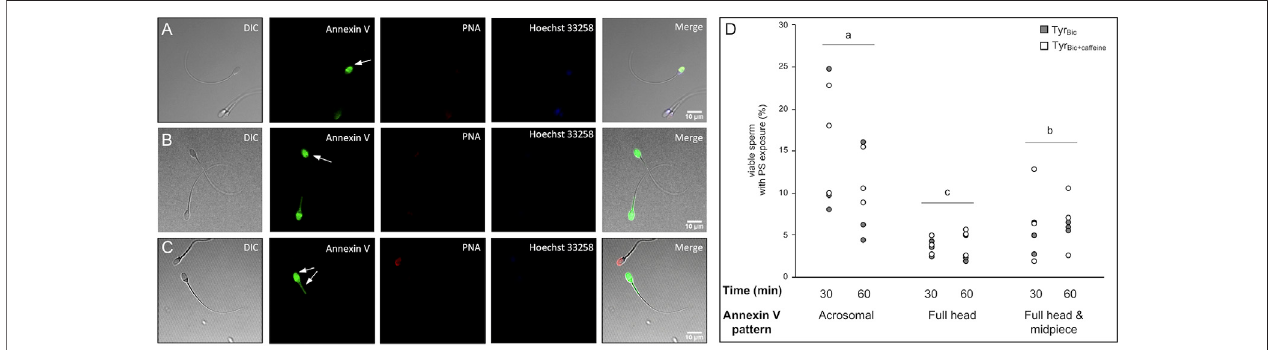
FIGURE7| Patternsofphosphatidylserine-exposureinviablestallionsperm.Spermatozoawereincubated either inthepresence of30 mMbicarbonate (Tyr Bic ) or Tyr Bic containing 1 mM caffeine (Tyr Bic+caffeine ). An exposure of phosphatidylserine (PS) in viable (Hoechst 33258 negative) sperm was detected using Annexin V-Fluos ( n (cid:2) 3 stallions). PNA-Alexa Fluor647 was included as an additional marker for acrosome integrity. Staining patterns for Annexin V were observed in the acrosomal area [ (A) ,arrow],acrossthecompleteheadregion[ (B) ,arrow]orinthecompleteheadandthemidpiece[ (C) ,arrows].Thefrequencyofeachpatternintheviablesperm population was determined after 30 and 60 min incubation time (D) . Differing letters (A – C) indicate signi fi cant differences between the abundance of each labelling pattern for Annexin V. There were no signi fi cant differences between timepoints ( n (cid:2) 12 samples per pattern; p < 0.05).